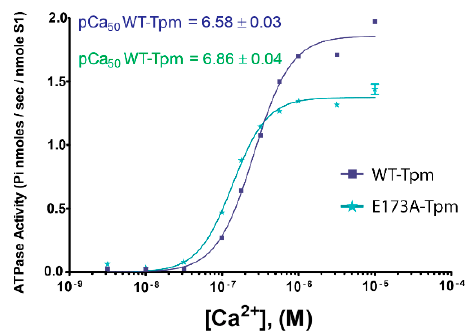
Figure 1. Effect of the E173A mutation in γ - tropomyosin (Tpm) on sensitivity of the thin filaments to activating Ca 2+ concentrations. Ca 2+ -dependence was determined for fully regulated reconstituted thin filaments. The acto-S1 ATPase was measured in the presence of wild-type (WT) Tpm (squares), and E173A-Tpm (stars) at 25 °C. Error bars indicate ±SEM. pCa values were calculated from data averaged from 3 experiments. Conditions are given in Section 3.